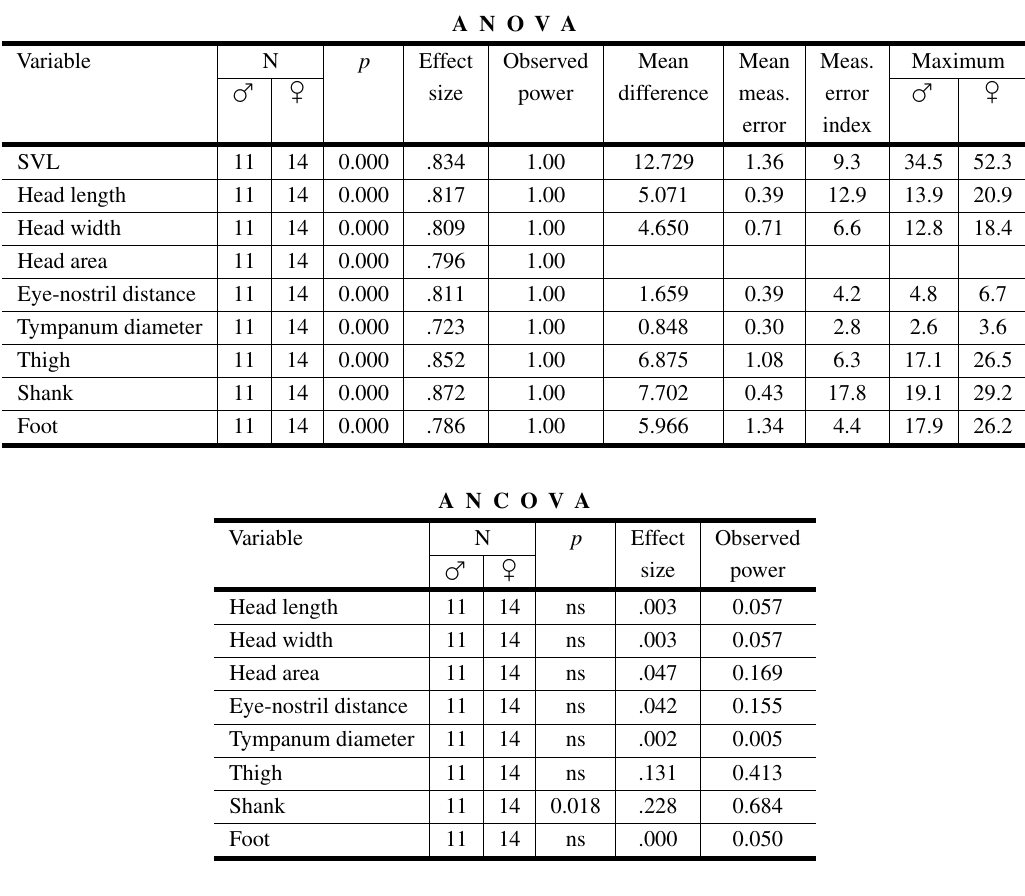
Sexual dimorphism statistics for Eleutherodactylus fenestratus measurement data. Meas. = measurement. All mean difference values are positive; female values are greater than male